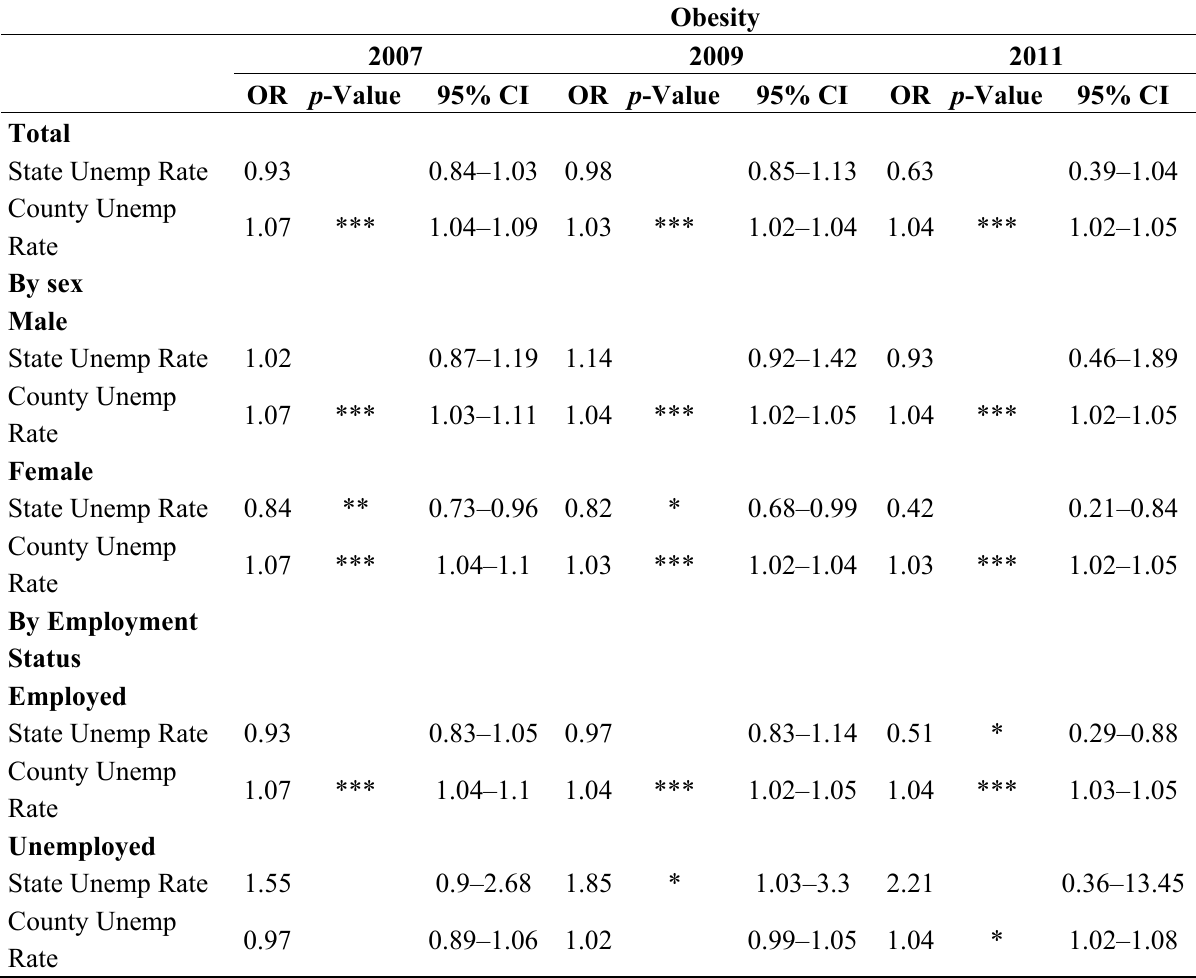
Table 4. Individual risk of obesity among BRFSS participants in 2007, 2009 and 2011 by state and county unemployment